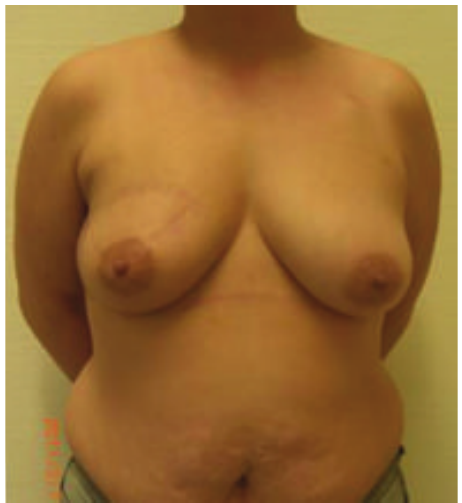
Figure 5: Same patient, 19-month follow-up; scar length 25 cm; BCCT.core: excellent. The patient was very satisfied with the cos- metic result. The scar visibility was rated as very visible by the patient and moderately visible by the experts. The volume discrepancy was rated as slight by the patient and not at all by the experts; frontal view.